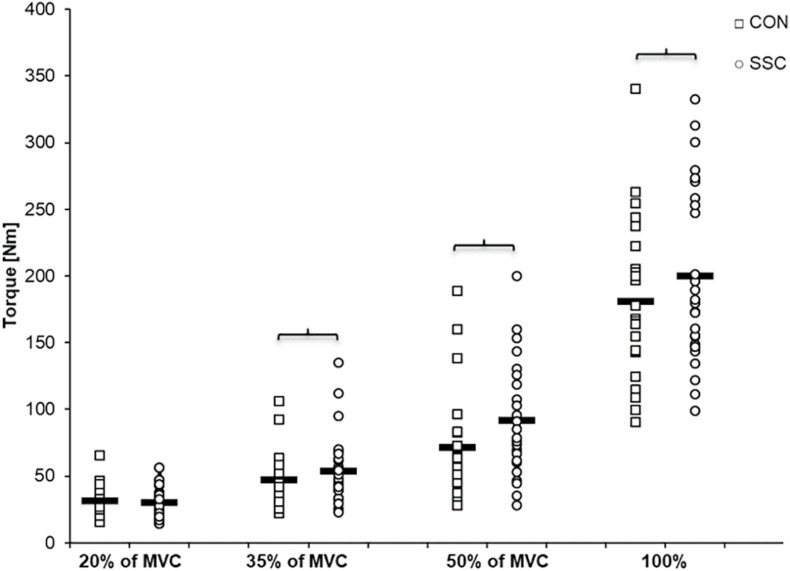
Mean (n = 27, thick horizontal line) (and mean of each individual subject) values of joint torque at the onset of shortening (T1). Squares represent concentric condition (CON), whereas circles represent stretch-shortening conditions (SSC). Braces indicate significant (p < 0.05) differences between CON and SSC at the same intensity level.